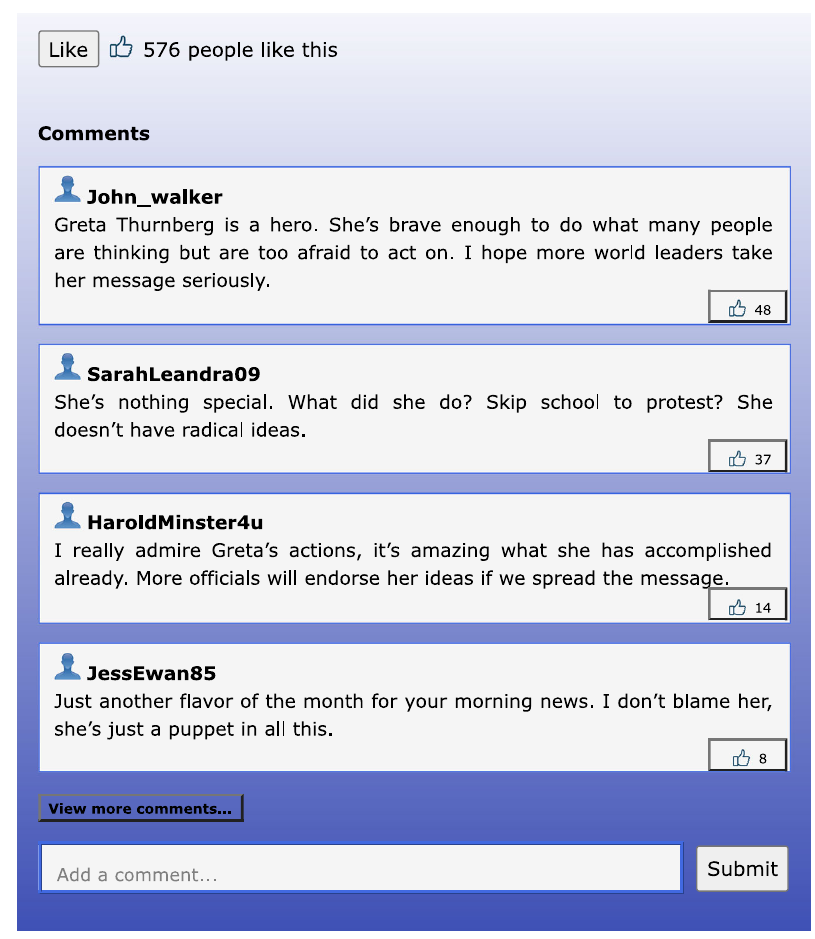
Fig. 1 Example of the mixed comment section and Likes manipulations. This comments section manipulation was presented to participants in group 5 (see Table 1). These comments and Likes (both under the article and under the comments) were presented below a news article about Greta Thunberg. The comments only comprised subjective